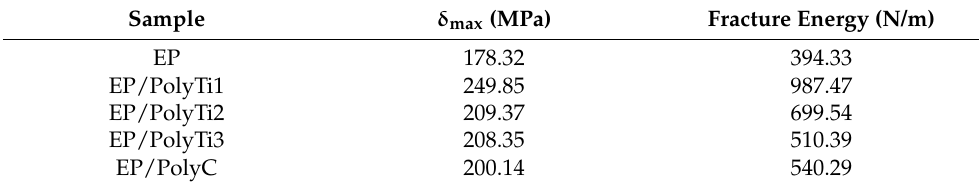
Figure 14. Stress–strain curves of the EP composites. Table 5. The data of three-point bending of EP